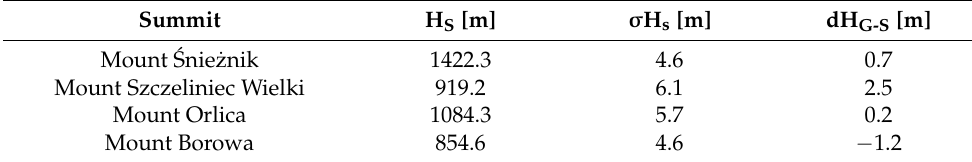
Figure 8. Mount Okole (725.3 m). The altitude difference between the rocks and the summit surface is approximately four metres. Author: Krystian Kozioł. Table 3. The results of measurements obtained using a Xiaomi Mi8